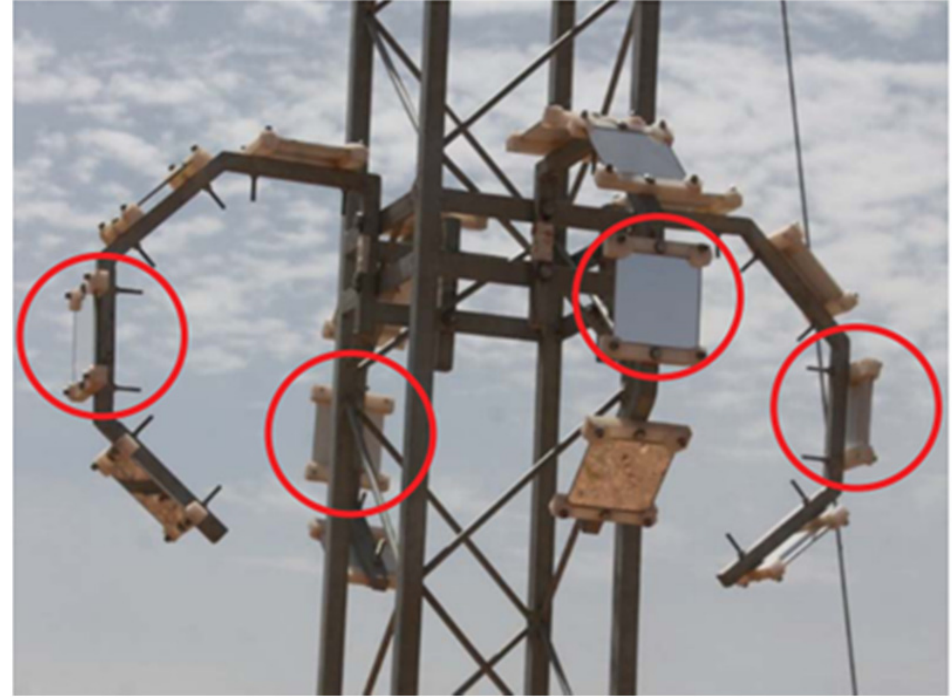
Figure 1. Exposure rack showing samples exposed in the four cardinal directions [13].